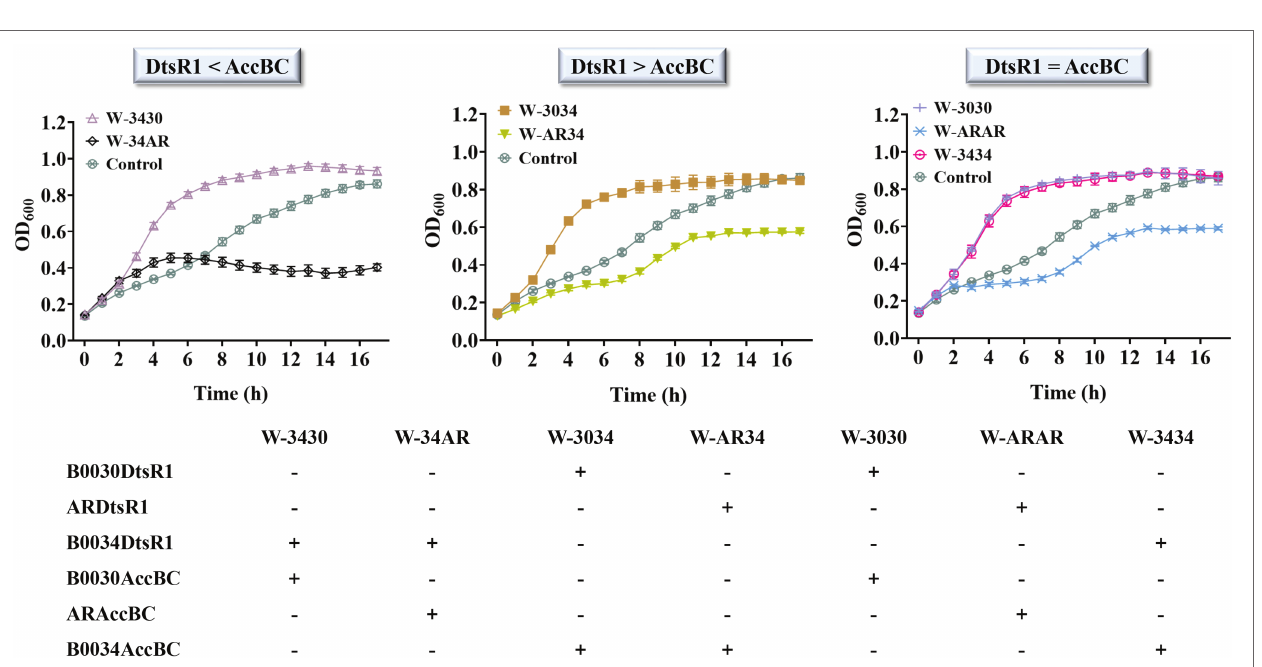
in the same plasmid with varying strengths of RBS. Finally,